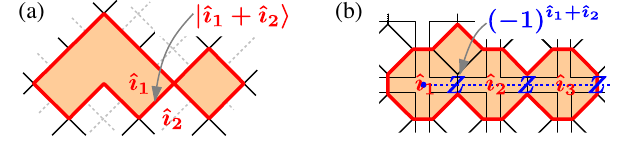
FIG. 10. Mapping of the toric code in a magnetic field to the Ising model; the mapping works on the space of closed loops. (a) The Ising variables are obtained by assigning color labels ˆ { to the plaquettes, where loops are the domain walls between different colors. (b) Z operators measure the difference between two adjacent colors, ð − 1 Þ ˆ { 1 þ ˆ { 2 . A magnetic flux ( Z string), thus, corresponds to a z correlator ð − 1 Þ ˆ { 1 þ ˆ { l between the Ising variables at its satisfied. ð σ x Þ ⊗ 4 p